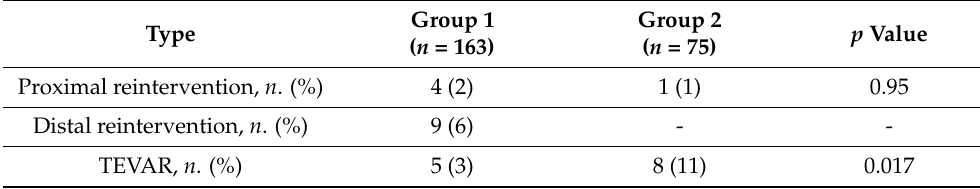
Table 6. Incidence and type of redo procedures in the 2